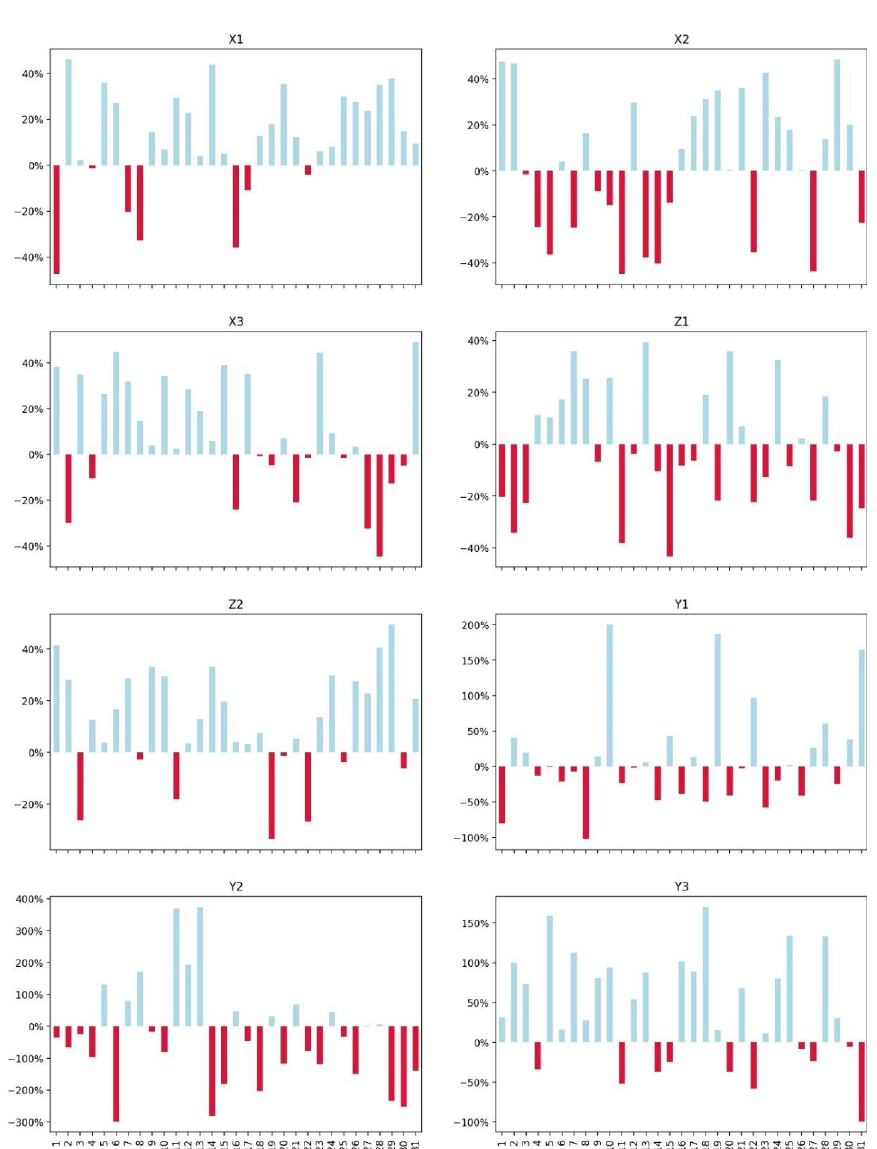
Figure 9. The percentage of changes needed to reach to maximum efficiency in the near